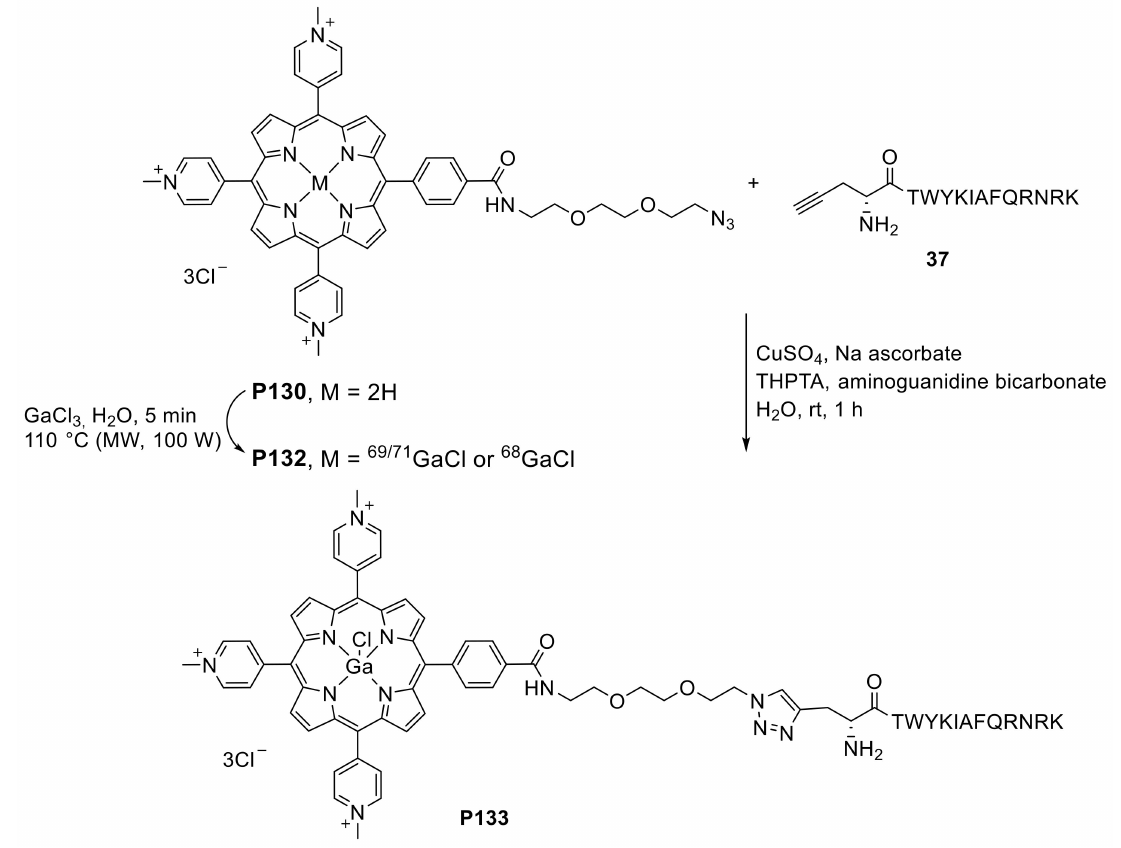
Scheme 44. Synthesis of a radiolabeled peptide-porphyrin